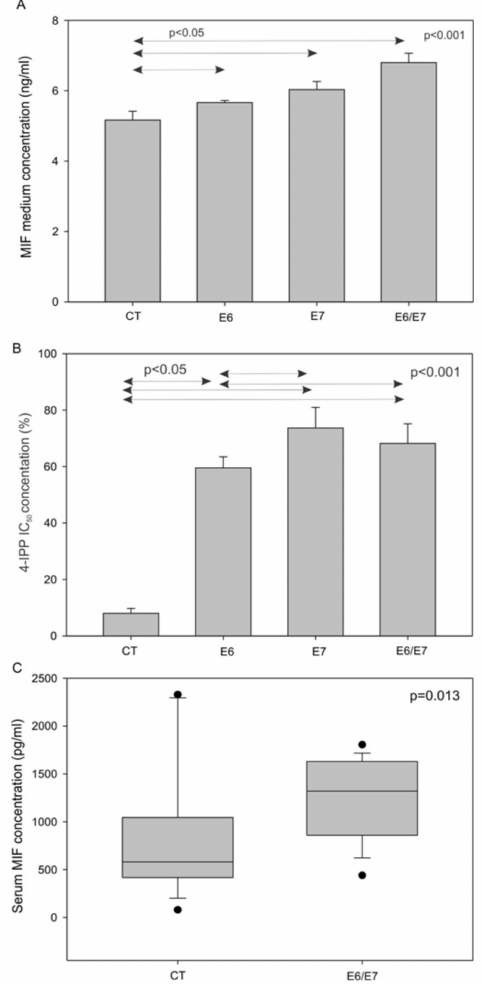
Figure 3. Macrophage migration inhibitory factor (MIF) secretion by murine cells in vitro and in vivo, and 4-IPP IC50 in murine cell lines. ( A ) Increase in the MIF concentration in the culture medium of SCCVII cells expressing HPV oncoproteins ( p <0.001, one-way ANOVA). ( B ) Percentage of cell proliferation after exposure to 50 µ M 4-iodo-6-phenylpyrimidine (4-IPP) in SCCVII CT, E6, E7 and E6/E7 cell lines ( p <0.001, one-way ANOVA test). ( C ) Increase in the serum MIF levels of mice receiving SCCVII E6/E7 cells (n = 18), compared to the serum MIF levels of mice in the control group (CT) (n = 16) ( p = 0.013, Mann–Whitney